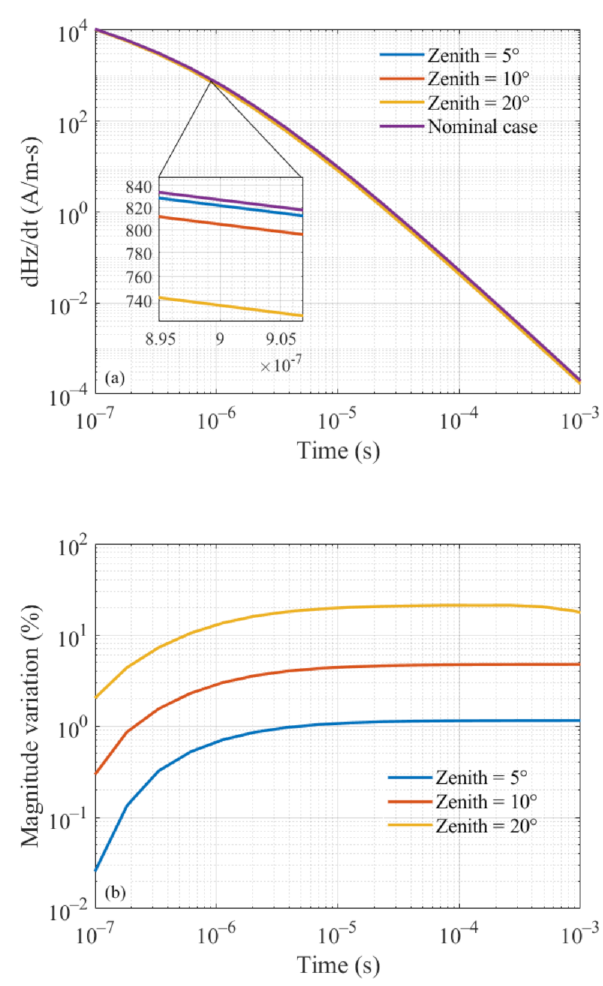
Figure 4. dHz/dt response to ATEM survey (central loop configuration) over a half-space with a conductivity of 0.01 S/m. ( a ) dHz/dt response to the nominal situation and the actual cases where the inexact geometry is considered. ( b ) mismatch in the magnitude between the nominal situation and the actual